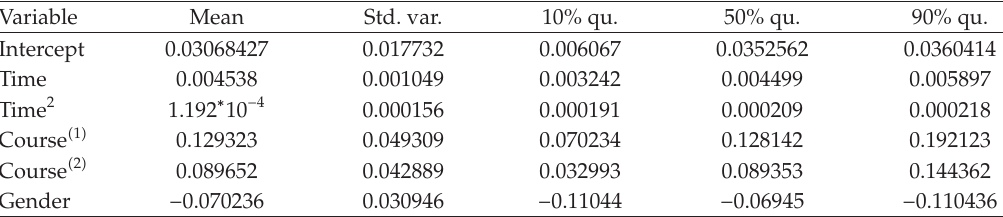
Table 8: Estimates of constant e ff